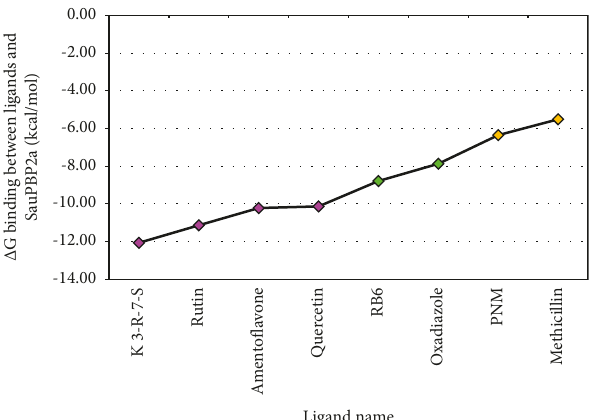
Figure 2: The estimated binding energy for top-ranked flavonoids and control compounds. X -axis: green and orange diamonds indicate control positive and control negative compounds, respectively. Y -axis represents the estimated binding energy (kcal/mol). K 3-R-7-S,